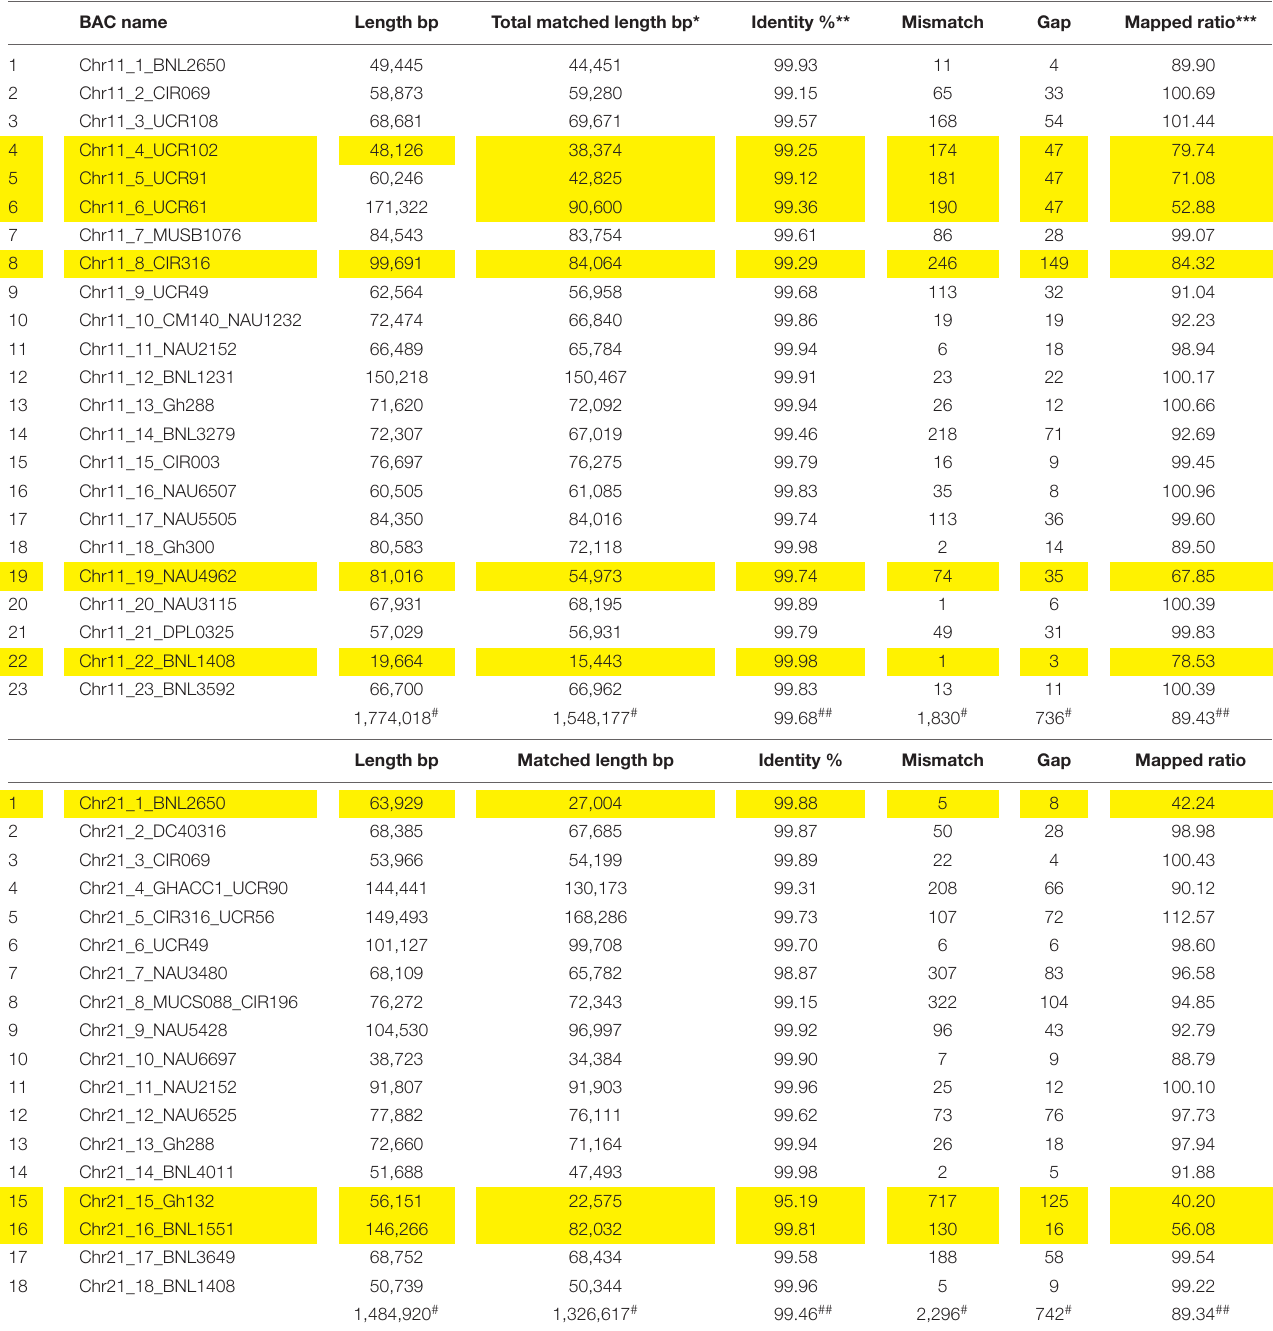
TABLE 2 | Summary of Chr 11–Chr 21 mapping to the TM-1 genome